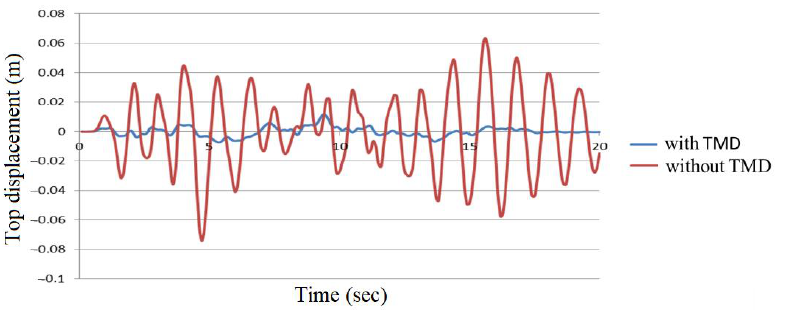
Figure 21. Comparison of the top displacement obtained by the nonlinear time-history analysis when the structure remains within the elastic range.